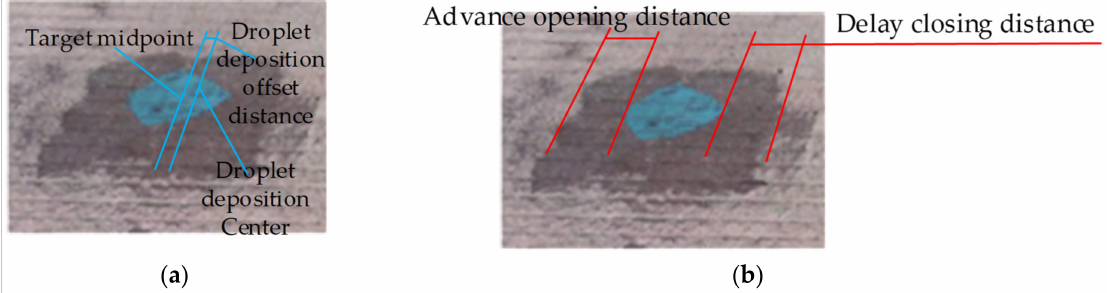
Figure 17. Comparison of evaluation methods between this study and others. ( a ) Evaluation method of reference [41]; ( b ) Evaluation method of this